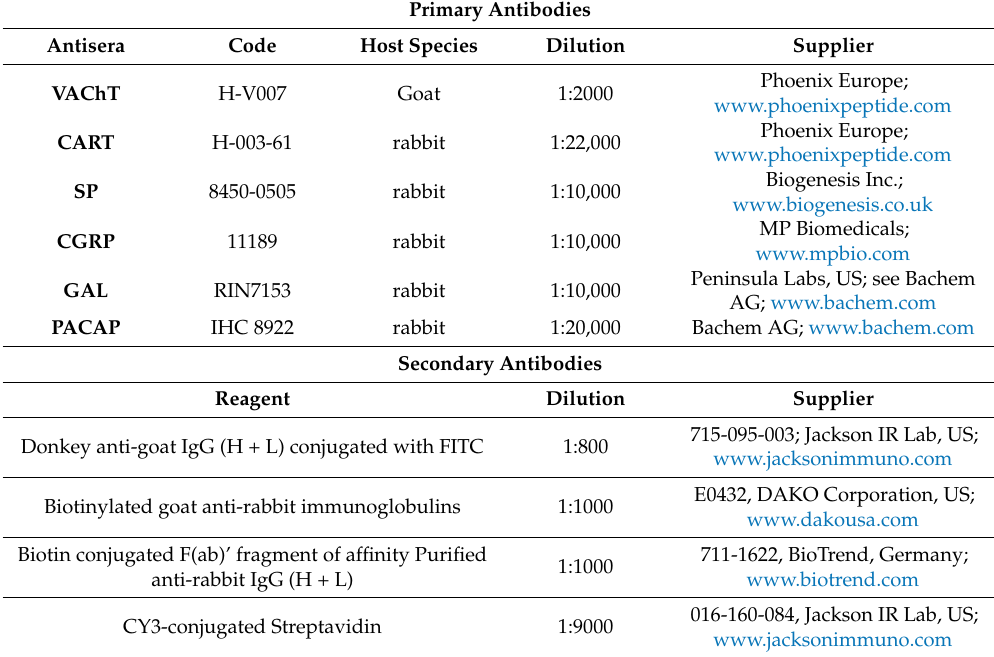
Table 2. List of primary and secondary antibodies used in this